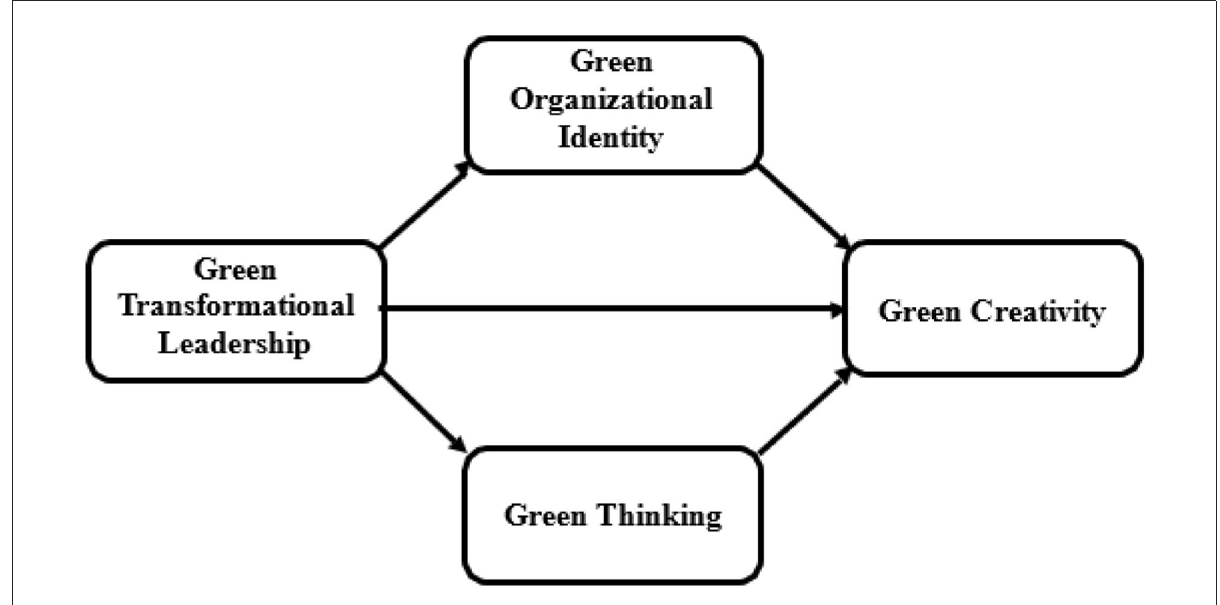
FIGURE1 Conceptual framework of the